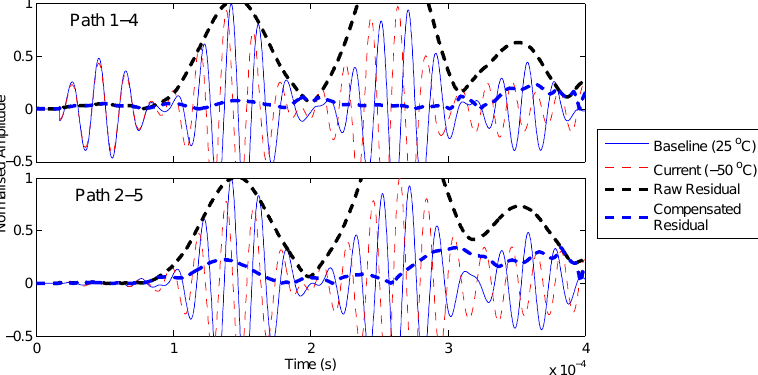
Figure 13. Current and damaged signal (50 kHz) for impacted SHM layer CFRP plate. Impact damage location far from the path 1–4 compared to the path